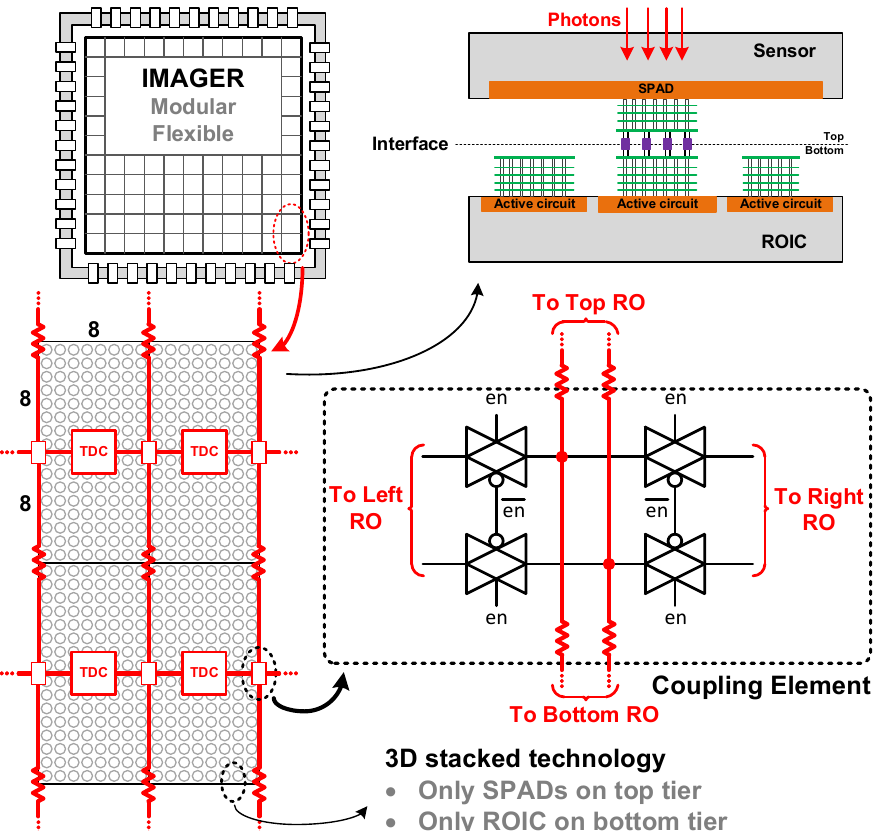
Figure 14. Transmission gate as resistive coupling element. 3D stacked technology